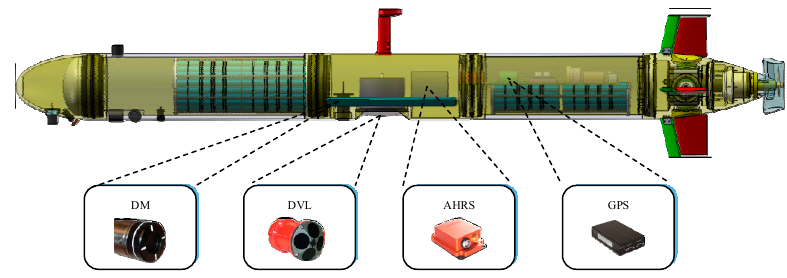
Figure 1. Structure of the Sailfish autonomous underwater vehicle (AUV).